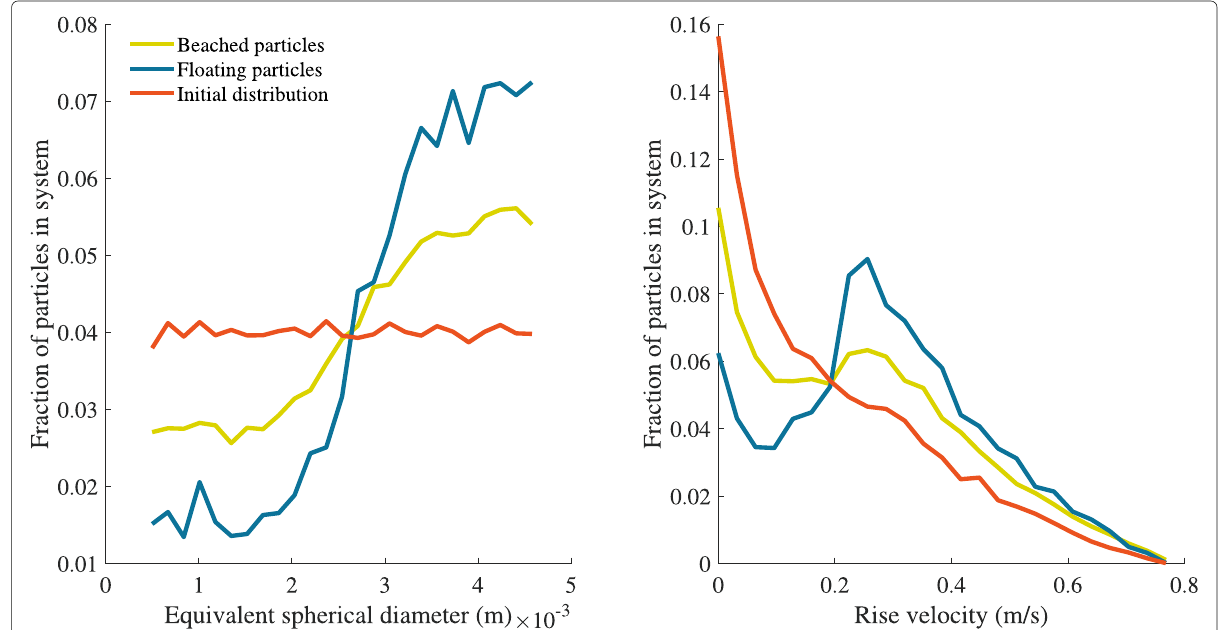
Fig. 4 Distributions of particle equivalent spherical diameter, or the diameter of a sphere of the same volume as the particle of irregular shape (left) and calculated rise velocities (right) in the system for beached and floating particles after a three year run. A floating particle has a positive rise